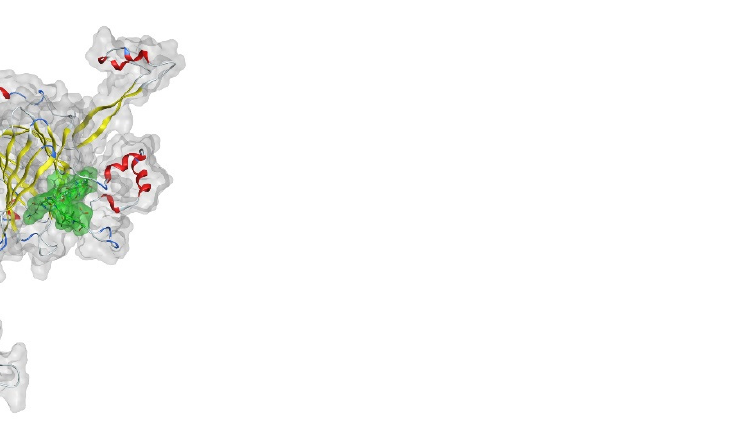
Figure S2. Alignment of the data available for 11S from the UniProt database; Figure S3.